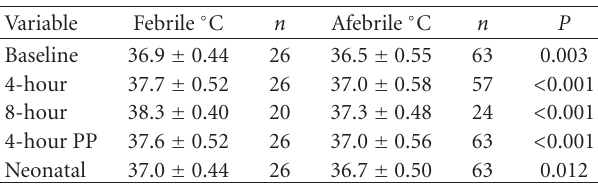
Table 2: Maternal and neonatal temperature changes in febrile and afebrile